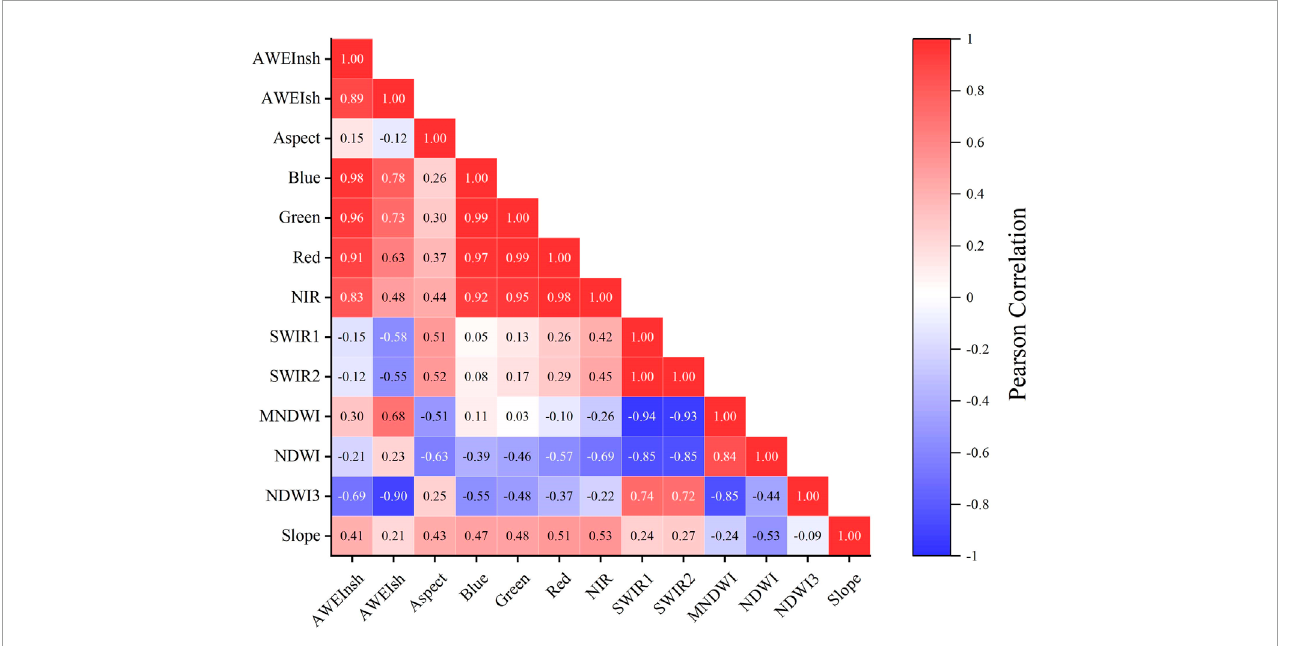
FIGURE 5 Pearson’s correlations between feature variables.